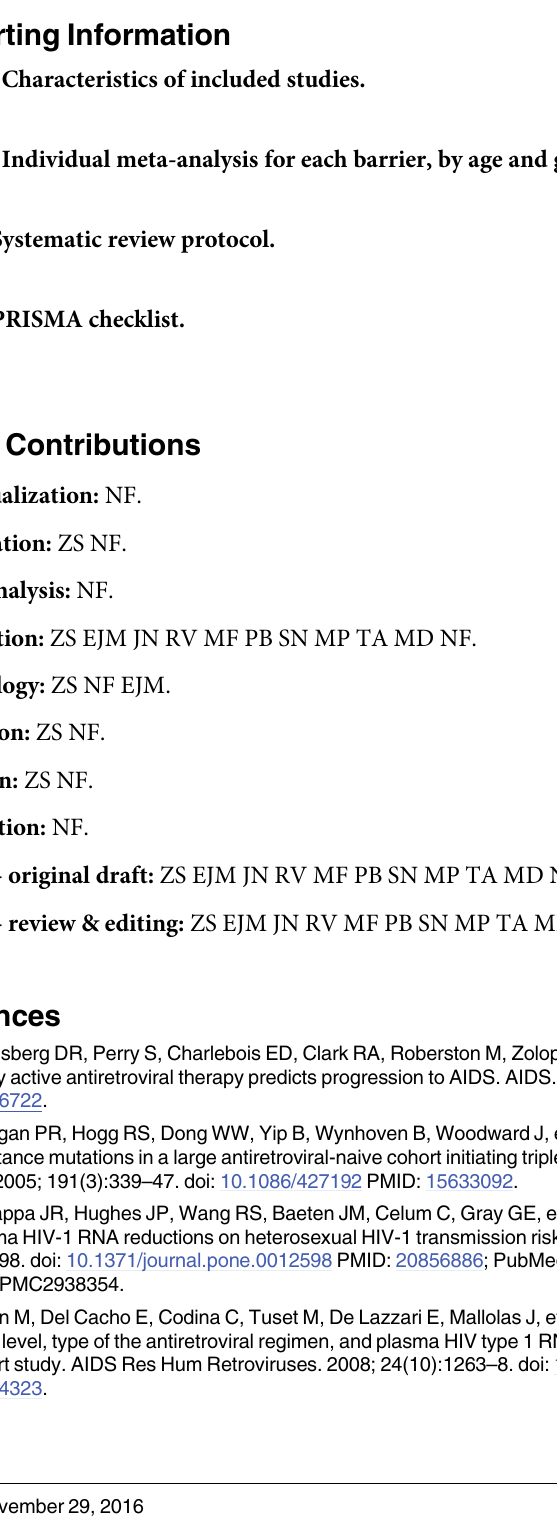
S1 Table. Characteristics of included studies. S2 Table. Individual meta-analysis for each barrier, by age and geographical